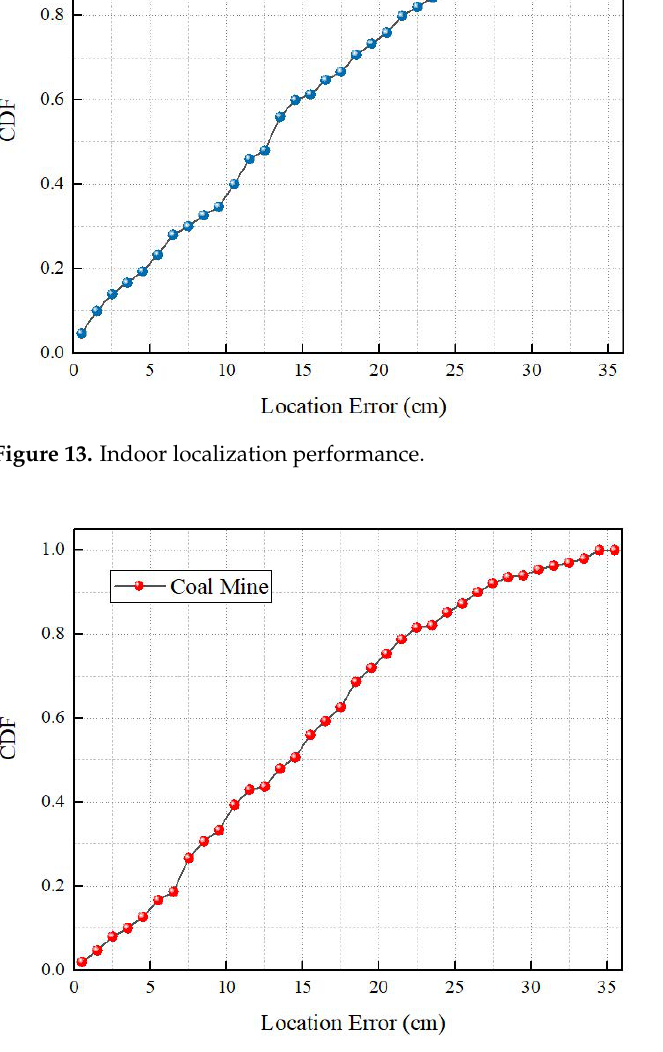
Figure 14. Underground localization